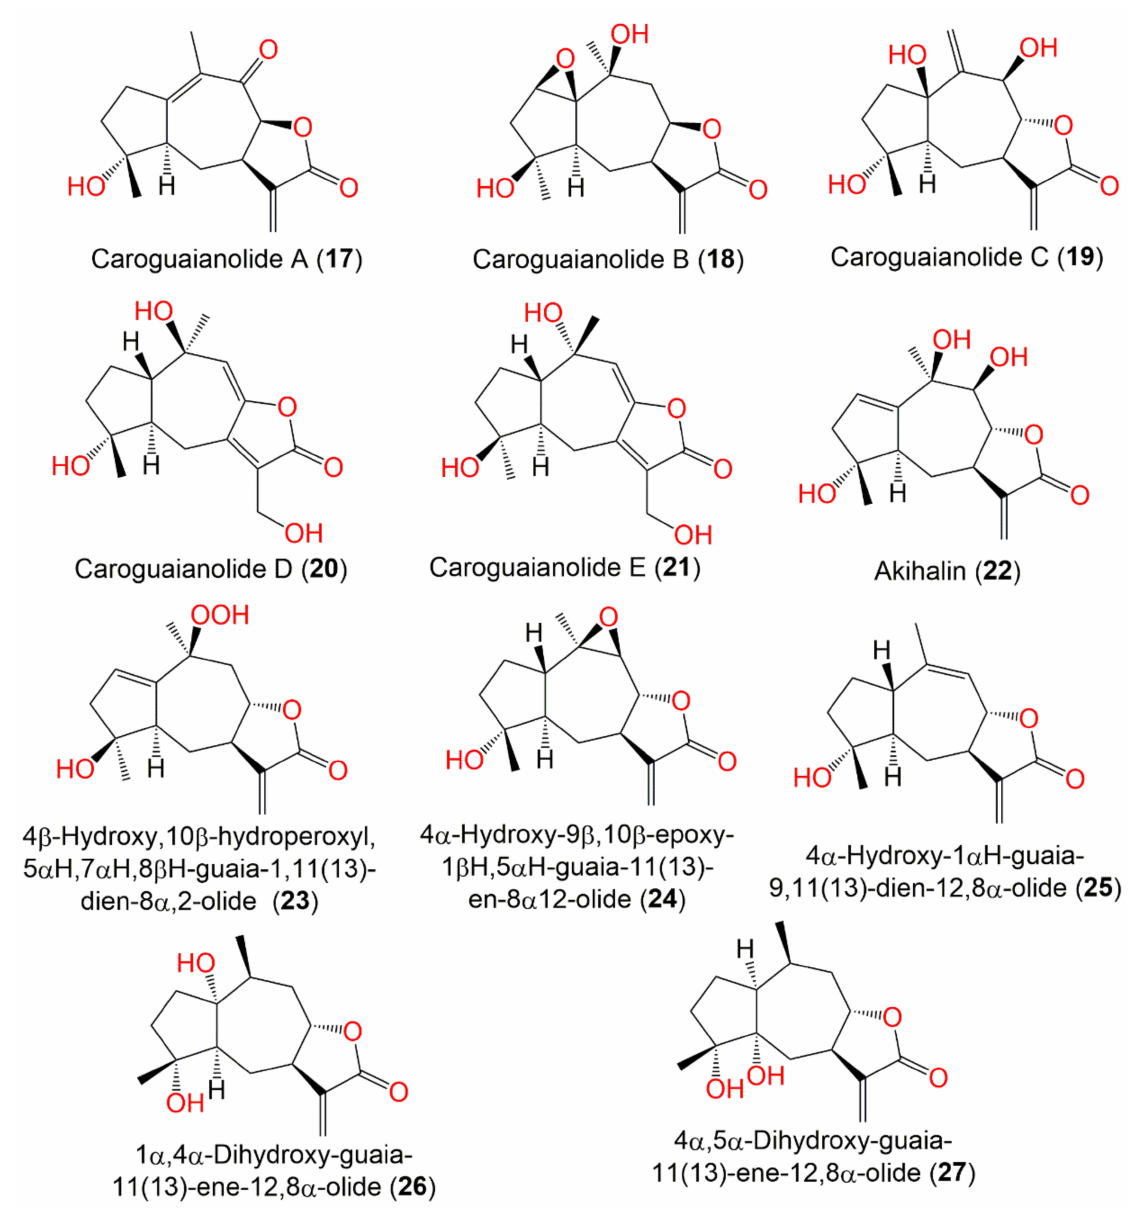
Figure 5. Guaianolide sesquiterpenes ( 17 – 27 ) reported from C. abrotanoides . In 2018, Hu et al. characterized new sesquiterpene lactones, 46 , 58 , and 59 , along with 13 , 31 , 37 , 55 , and 56 from the whole plant EtOAc fraction (Figure 6). Compound 46 was similar to 37 except for the existence of a C-12 methyl group instead of the exocyclic methylene in 37 . On the other side, 58 and 59 were analogs of 56 with a C-4 palmitoyloxy and linoleoyl group, respectively, instead of C-4 OH in 56 . Only 58 possessed cytotoxic influence versus the HL60 cells (IC 50 45.85 µ M) in the MTS method [53]. Telekin ( 35 ), 2 α ,5 α -dihydroxy-11 α H-eudesma-4(15)-en-12,8 β -olide ( 41 ), and oxoeudesm- 11(13)-eno-12,8 α -lactone ( 45 ) (Figure 7) demonstrated cytotoxic potential versus HepG-2, where 35 and 45 (IC 50 s 2.95 and 4.15 µ M, respectively) with γ -lactone- α -methylene moiety had more potent effects than 41 (IC 50 9.83 µ M). These metabolites noticeably reduced the STAT3 and JAK2 mRNA expression as well as prohibited the p-STAT3 and p-JAK2 expression in the HepG-2 cells. Hence, their antiproliferative potential versus HepG-2 was due to STAT3/JAK2 signaling pathway suppression